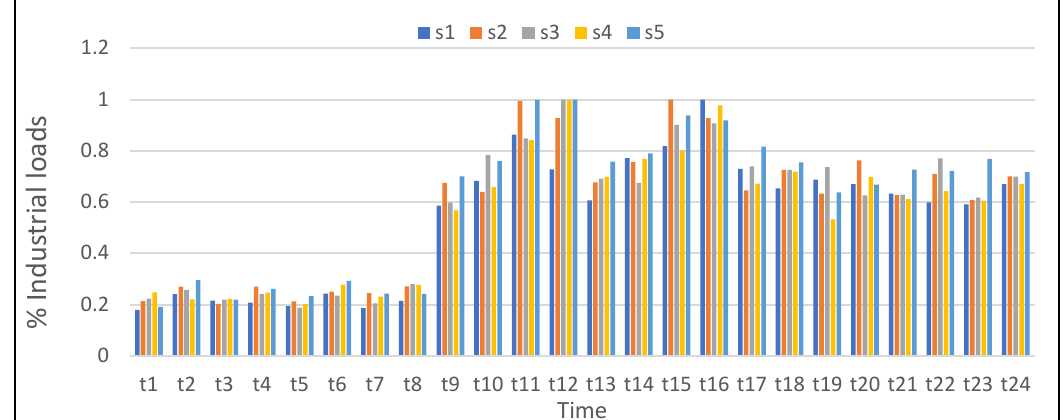
Figure 7. Daily demand profiles for commercial loads.